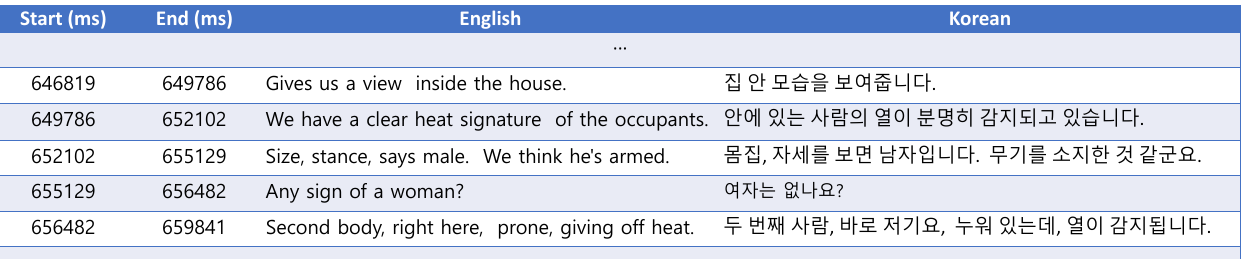
Figure 7. Example parallel sentence pairs extracted from bilingual